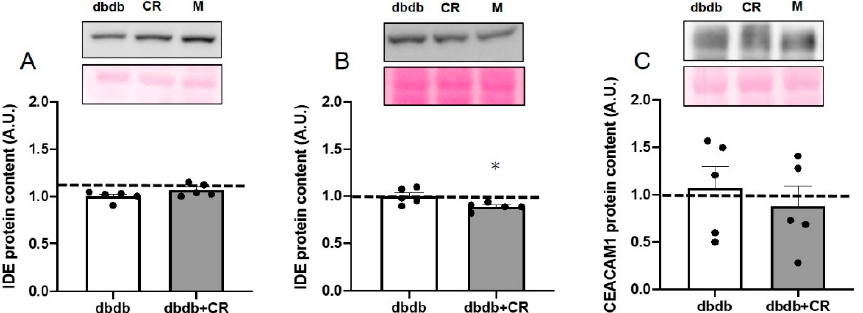
Figure 5. Effects of calorie restriction on insulin-degrading enzyme (IDE) and carcino-embryonic antigen-related cell adhesion molecule 1 (CEACAM1) levels in db/db mice. IDE protein levels in mouse tibialis anterior muscle ( A ) and liver ( B ) and CEACAM1 protein levels in liver ( C ). dbdb, ad libitum-fed control group; dbdb+CR, daily calorie restriction group. Data of misty mice were used as reference values (dotted lines). Data are the mean ± SEM ( n = 5). * p < 0.05 compared with the dbdb group.